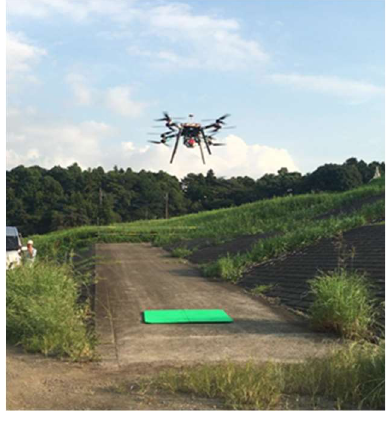
Figure 2. UAV LiDAR,